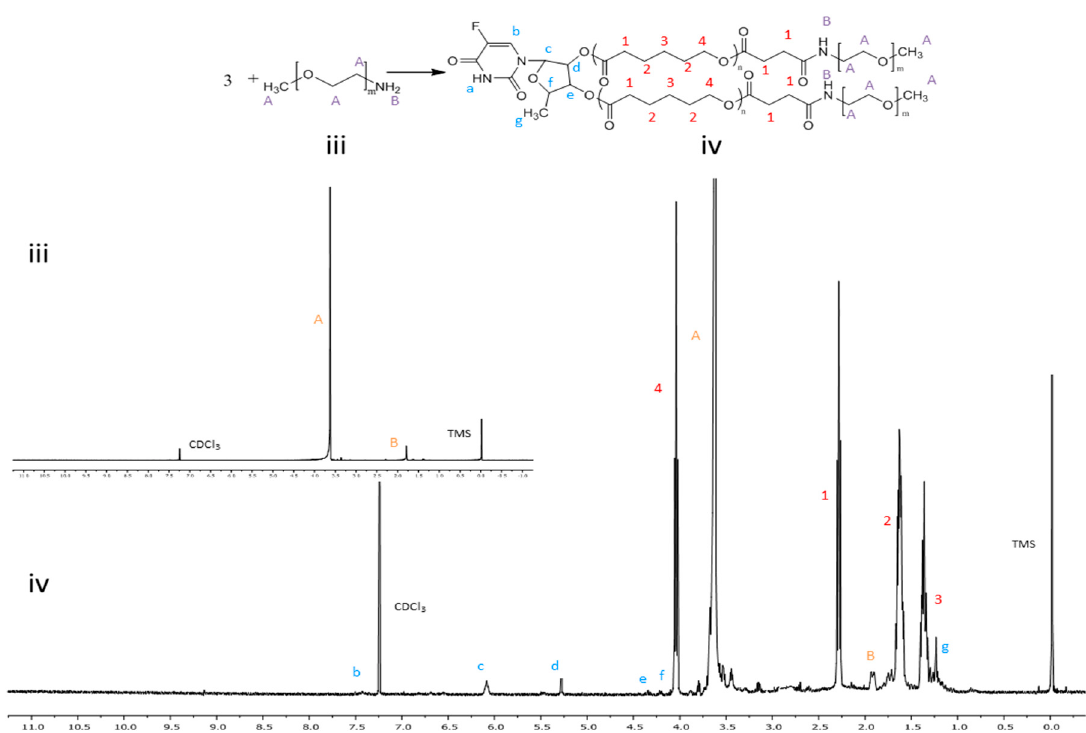
Figure 3. 1 H NMR spectra of ( iii ) MPEG and ( iv ) 5’-DFUR-PCL-MPEG.